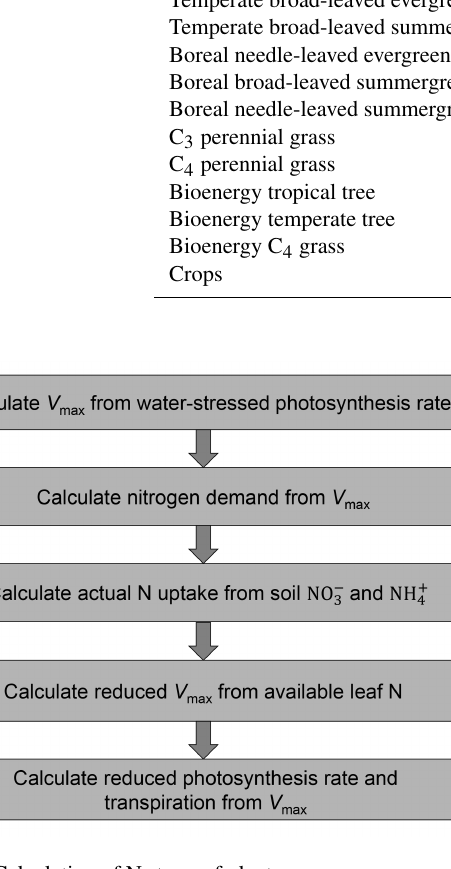
Figure 2. Calculation of N stress of